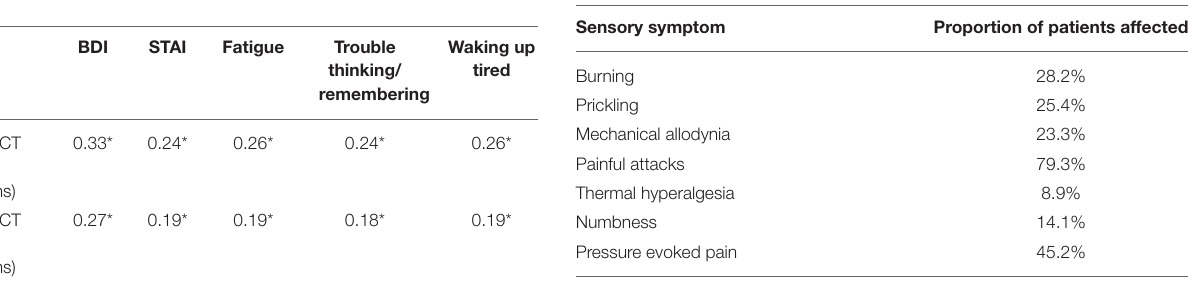
TABLE 4 | Reported symptoms in neuropathic and mixed